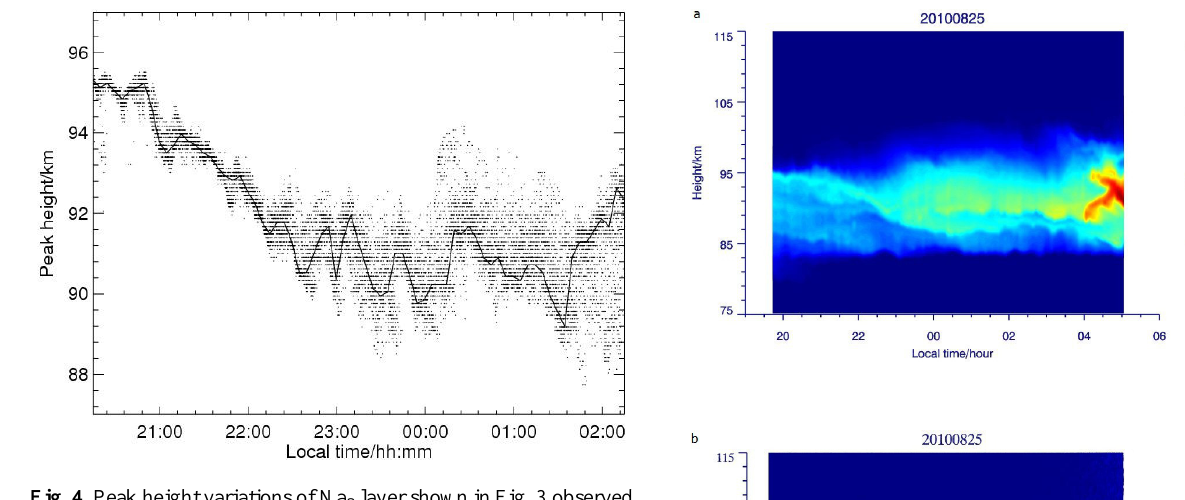
Fig. 4. Peak height variations of Na s layer shown in Fig. 3 observed at different time resolutions, the dots representing the 1.5s resolu- tion, and the solid line corresponding to 5min resolution.